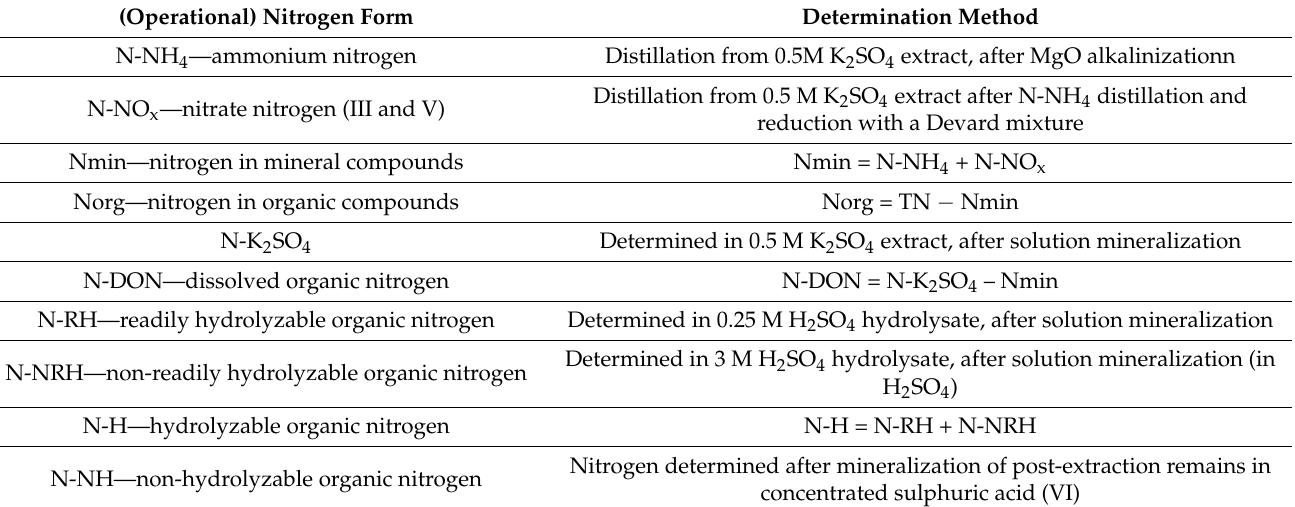
Table 1. Nitrogen forms and determination methods.